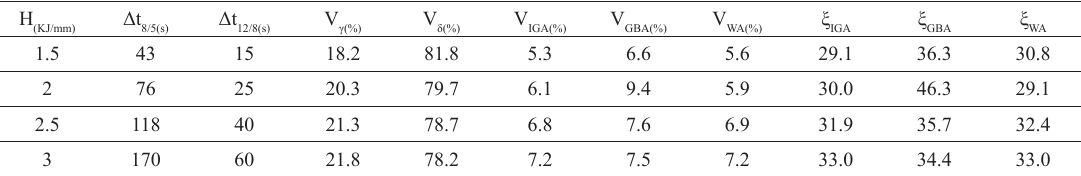
) and ferrite (V ) volume fractions at different cooling times at the HAZ microstructures of the UNS S32304 DSS. Table 4: Austenite (V γ δ V , V and V are the austenite volume fractions taking into account their morphologies. Heat input (H), the ξ GBA IGA WA the ratios between the volume fraction of the different austenite morphologies and the total austenite volume fraction.